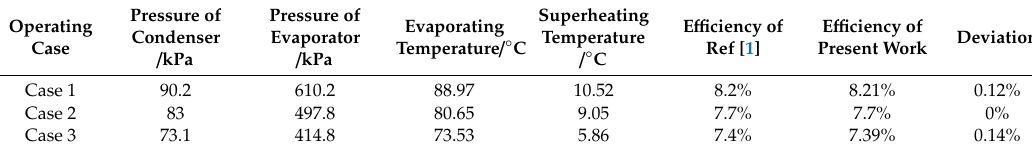
Table 1. Model validation for organic Rankine cycle (ORC).